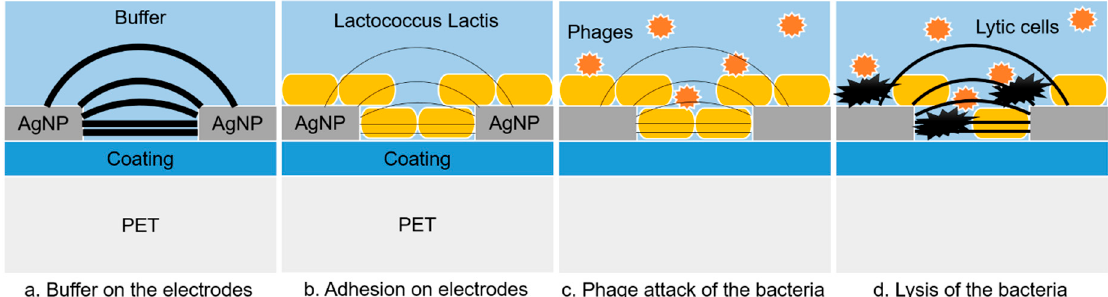
Figure 10. Representation of the influence of the bacterial presence and of the phage infection on the electrical field intensity (the thicker, the higher) between two interdigitated electrodes (not to scale). PET: polyethylene